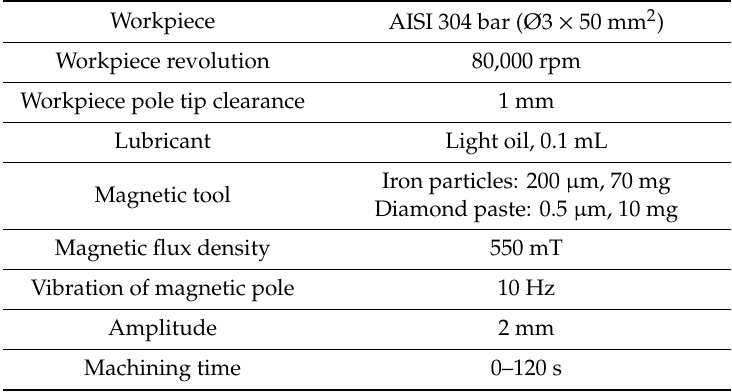
Table 2. Mechanical and physical properties of AISI 304 cylindrical bar.